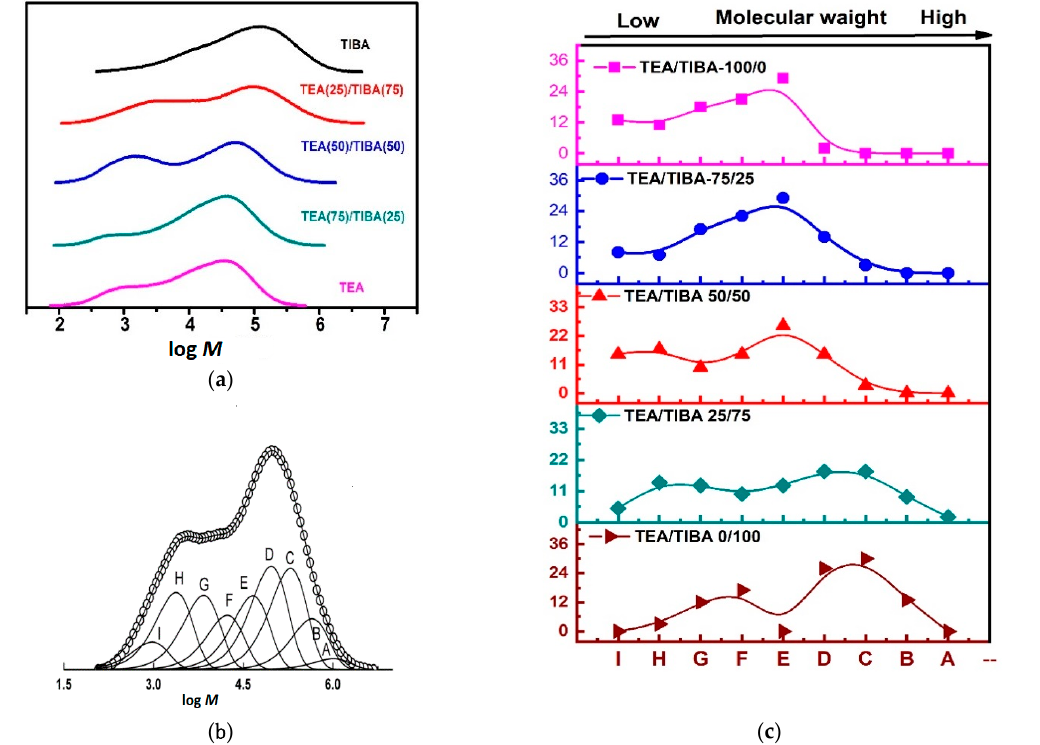
Figure 6. ( a ) MWD curves of PE produce with Mt-I/borate-I and TEA/TIBA mixtures, ( b ) deconvolution of PE MWD curve into Flory components (run 1.2 in Table 1, ( c ) distribution of Flory components of PE produced from Mt-I/Borate-I with various mixtures of TIBA/TEA. and the weight fraction of the Flory component (see supporting information, Table S2). It